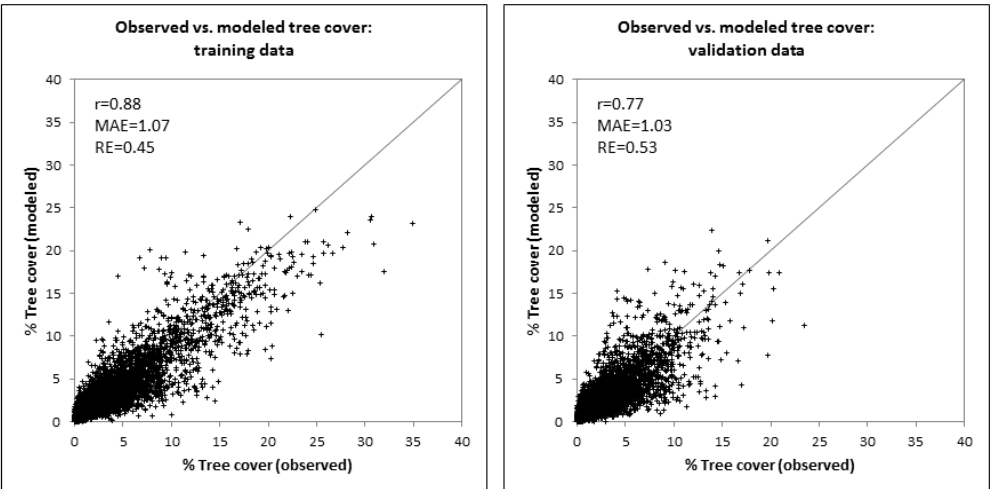
Figure 5. Graphs of observed and modeled percent tree cover for the training and validation datasets (MAE = Mean absolute error, RE = Relative